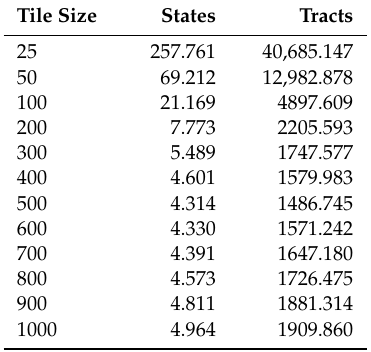
Table 10. GeoTrellis zonal operator performance time in seconds on GLC for states and tracts.